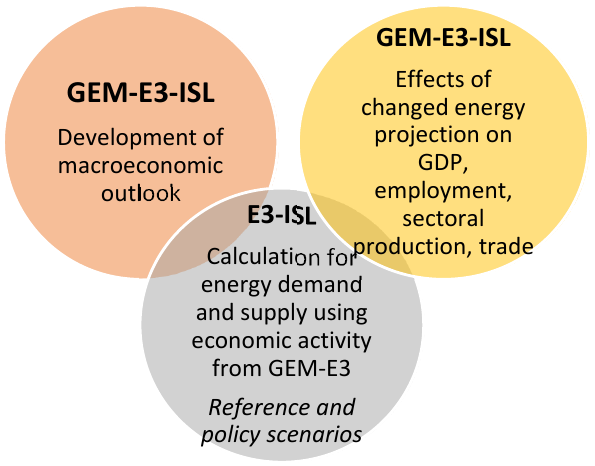
Figure 5. Soft-link between the energy and the macroeconomic island-scale Figure 5. Soft ‐ link between the energy and the macroeconomic island ‐ scale models .